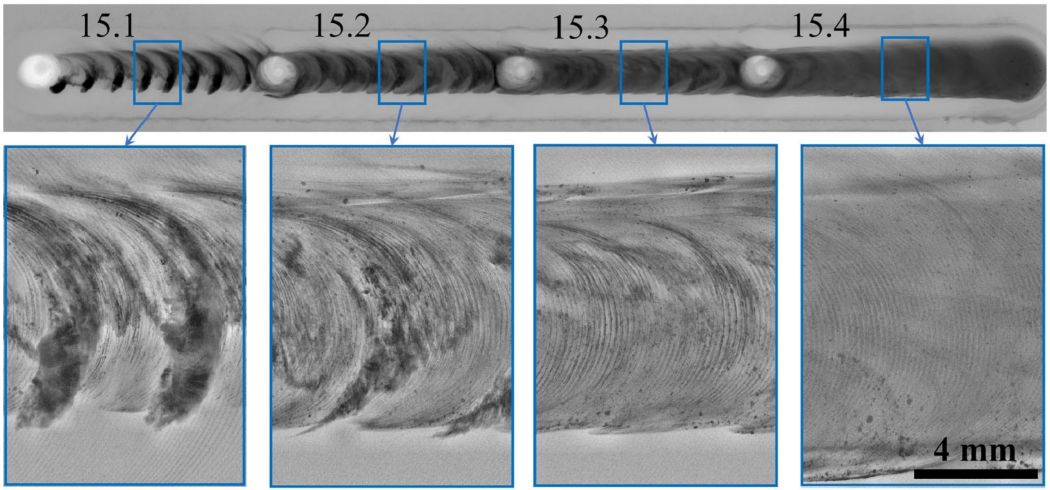
Figure 7. CT images of the processed area of Al-Mg-Sc alloy with 15 wt% Mo.